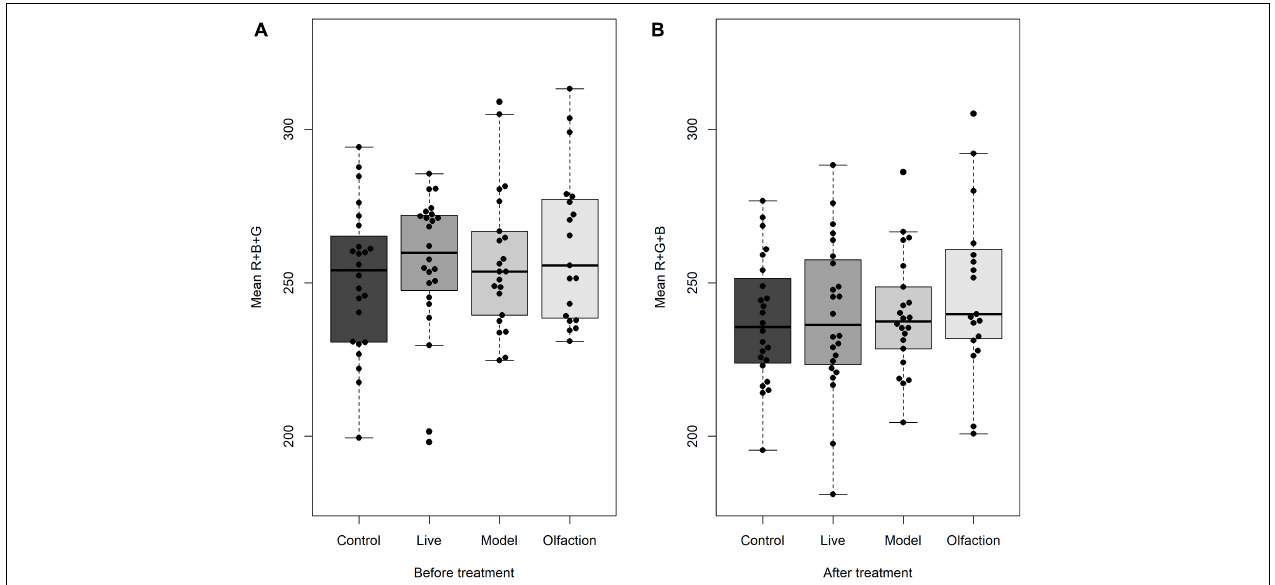
FIGURE 2 | Lumpfish skin color ( n = 24) measured as mean Red + Green + Blue pixels (A) before and (B) after treatment exposure. Mean R + G + B did not deviate between treatments before or between treatments after the experiment. Lumpfish were reared in experimental tanks with Live Atlantic salmon or different salmon sensory cues (Olfaction and Model). Boxplots describe median values with quantiles and